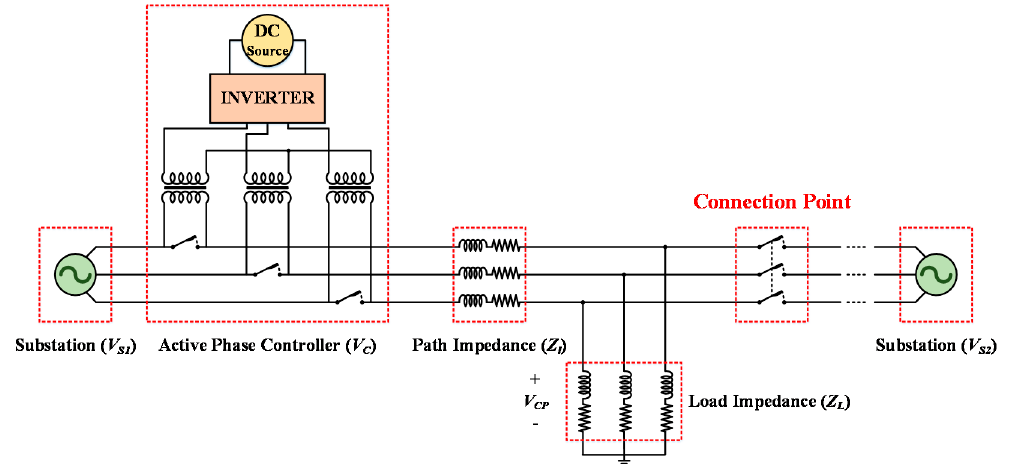
Figure 1. Diagram representing connections between the distribution lines.